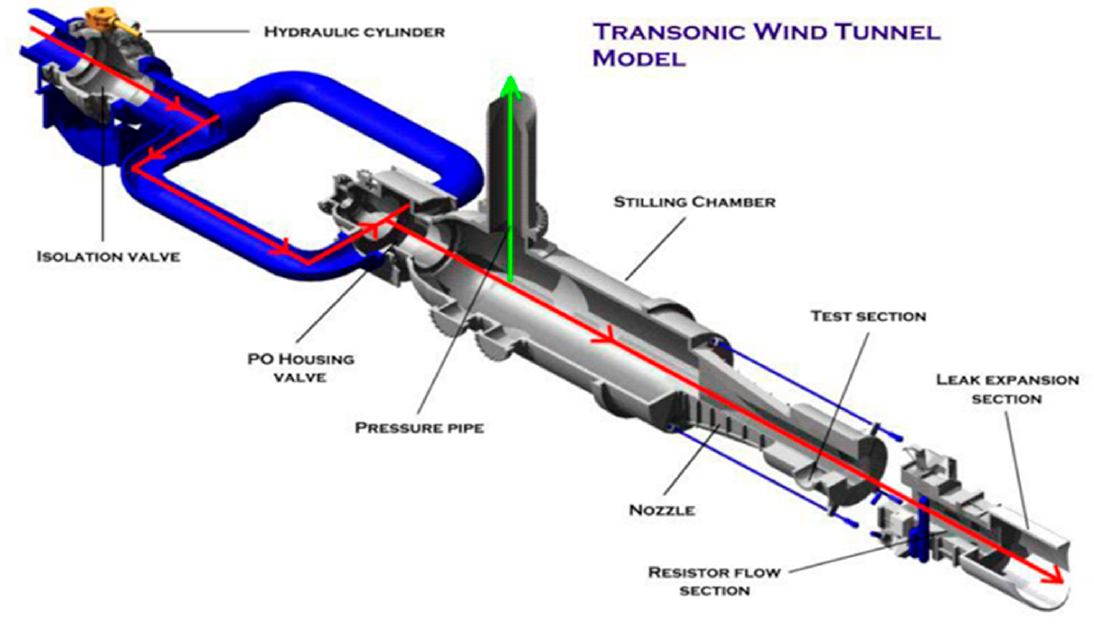
Figure 3. Transonic wind tunnel at ASTRC/NCKU.